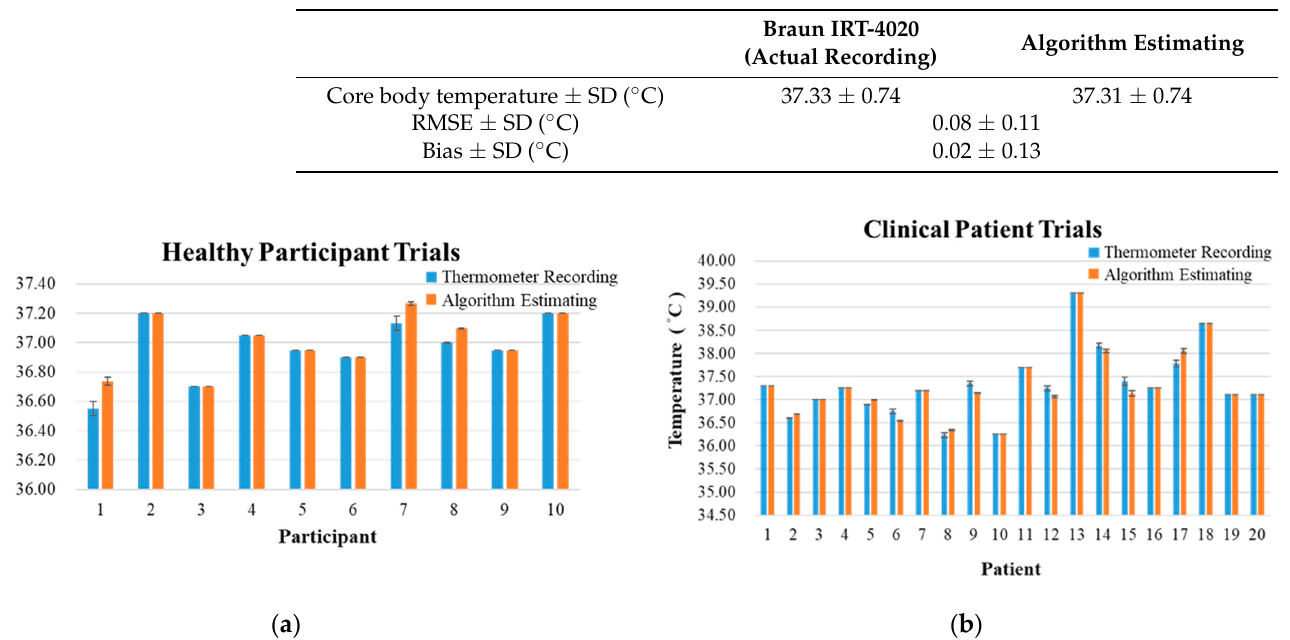
Figure 9. Measured and algorithm estimating values of ( a ) healthy participant and ( b ) clinical patient trials for the core body temperature algorithm. The measurement of core body temperature is represented in degrees Celsius (°C).